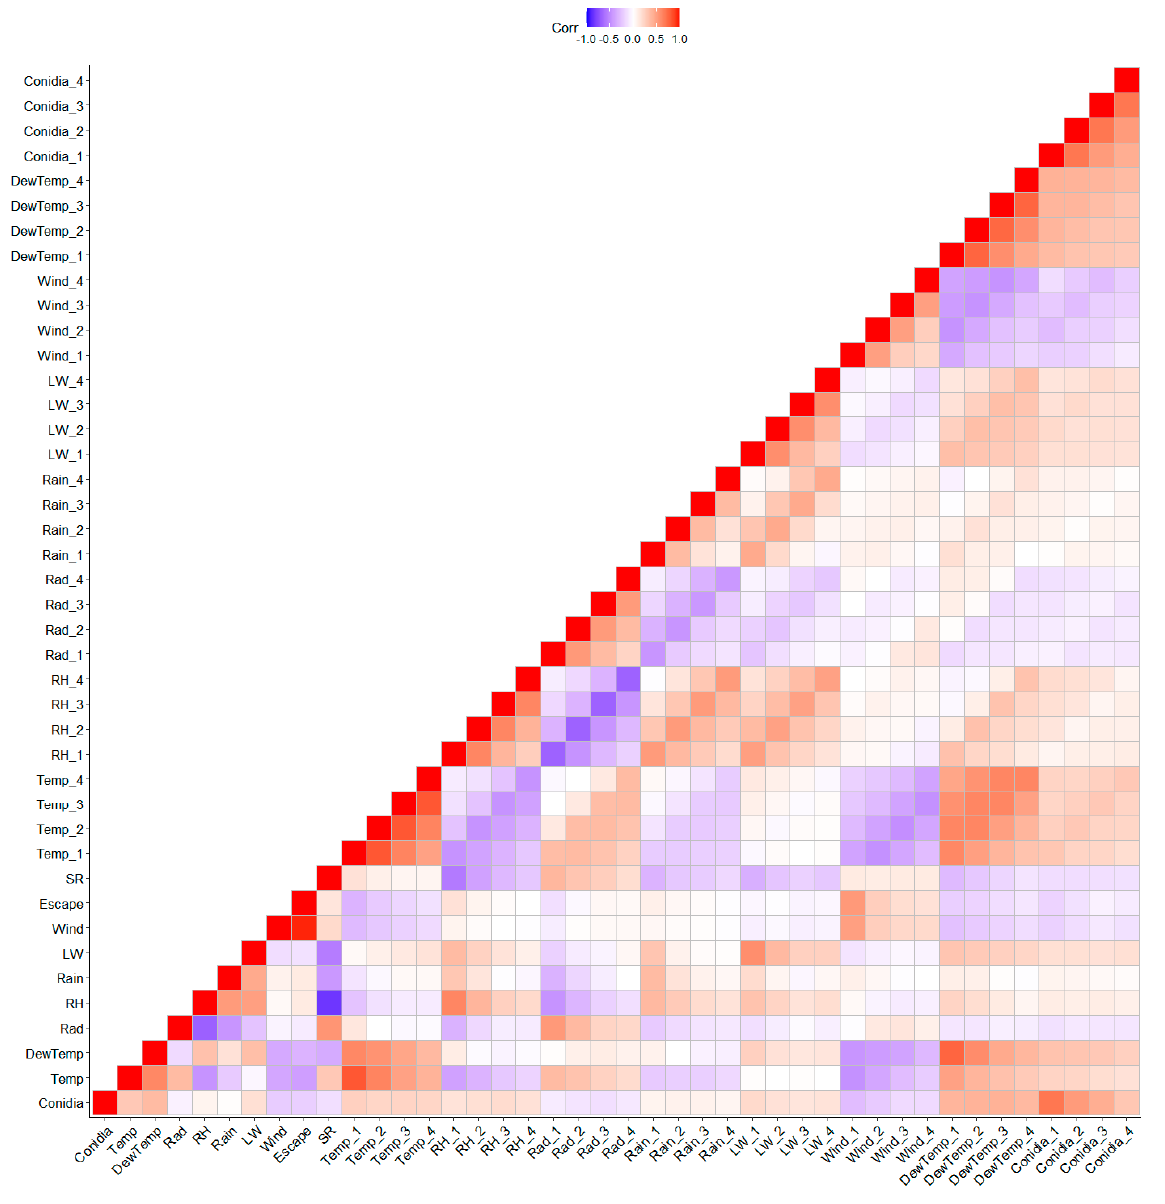
Figure 9. Heatmap with Spearman correlations between daily conidia concentration and weather parameters. The selected weather variables were relative humidity (RH), temperature (Temp), wind speed (Wind), dew temperature (DewTemp), leaf wetness (LW), solar radiation (Rad), and rainfall (Rain). The variable (weather and conidia) numbers 1, 2, 3, and 4 indicate measurements taken 1, 2, 3, and 4 days ago, whereas those without numbers were measured or recorded on the current day.